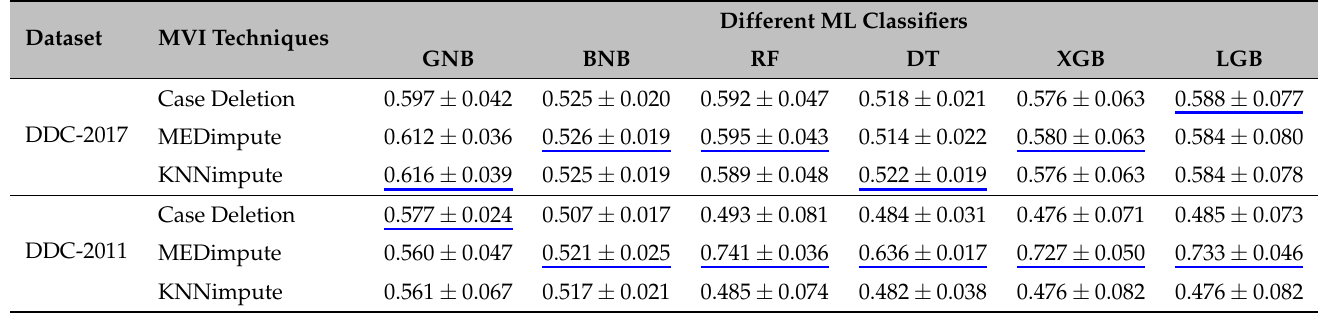
Table 4. Comprehensive empirical findings for missing value imputation in terms of AUC, utilizing three distinct imputation techniques, two distinct DDC datasets, and six separate ML classifiers. The best imputation strategy has been seen in the blue underline for each dataset and classifier.